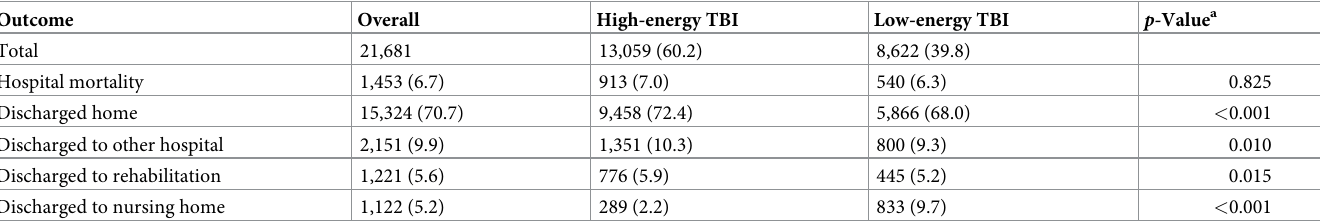
Table 4. Hospital mortality and discharge destination from study hospital (21,681 patients).